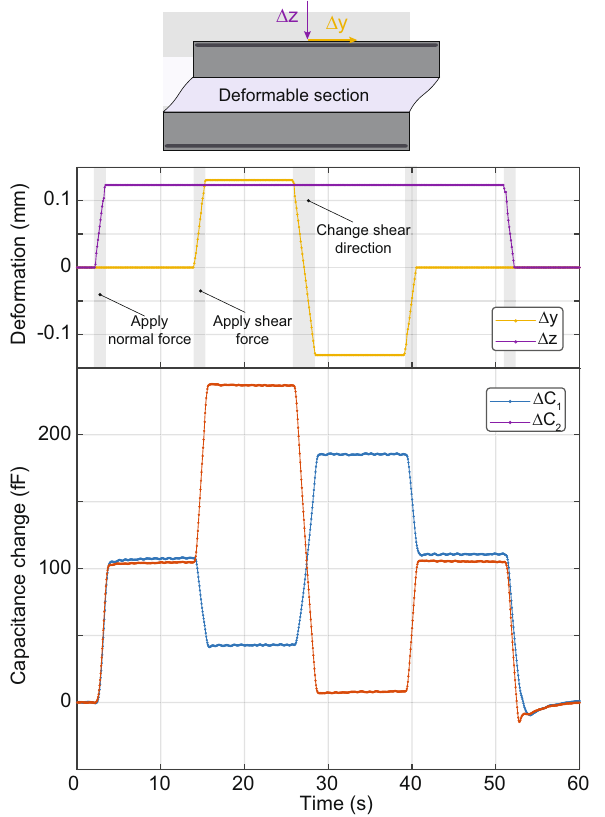
Fig. 4 | Capacitance change of a liquid metal sensor under simple normal and shear deformations. The schematic shows the shear ( y ) and normal ( z ) force directions. The top graph plots the time dependence of the normal and shear deformations applied to the sensor. The sensor is fi rst compressed by applying deformation in the − z direction (normal force). It is then additionally deformed in the+ y direction(+normal+shear).Thesensoristhendeformedinthe − y direction whilethenormalforceiskeptconstant(+normal − shear).Theshearforceandthen the normalforceare removed.The time evolution of the capacitances isplotted in thebottomgraphasthesensorgoesthroughthesesteps.Whenthenormalforceis applied, both capacitances increase. The shear force, however, changes the capa- citances in the opposite ways, e.g., decreasing Δ C 1 while increasing Δ C 2 . Similarly, Δ C fl ipping the shear force direction increases Δ C 1 and decreases 2 . Fig.5|Sensorcharacterizationprocedure.a Sequenceofmotionthatisrepeated as the stage is moved in the z direction. b The normal and shear forces measured (load cell) during the characterization vs. time. c The time evolution of the two capacitances measured by the liquid metal